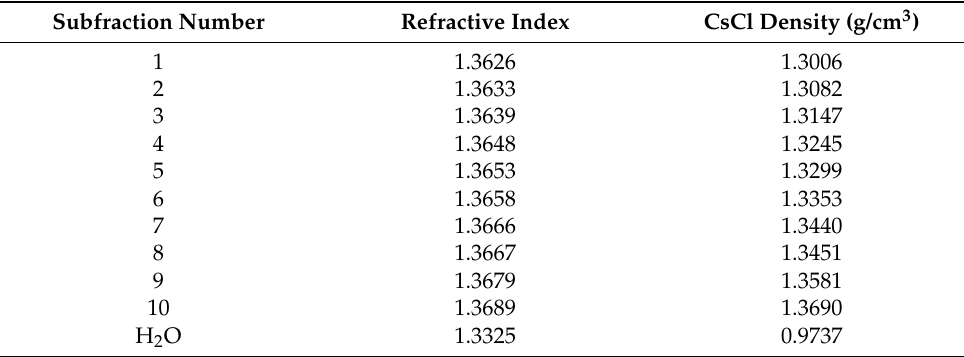
Table 1. Refractive index and density of each